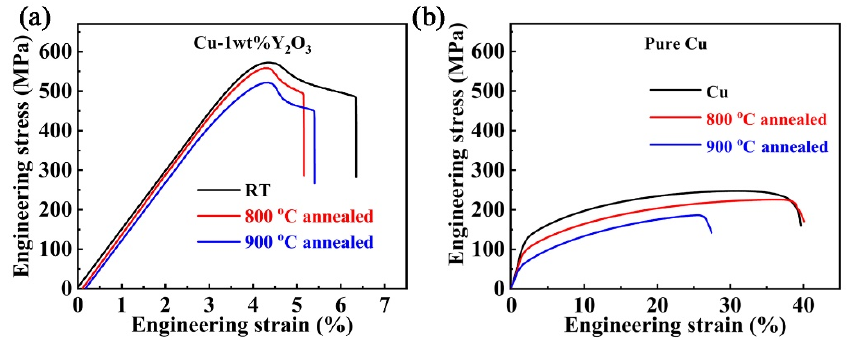
Figure 7. Tensile engineering stress-strain curves of ( a ) Cu-1wt.%Y 2 O 3 and ( b ) pure Cu before and after annealing at different temperatures.